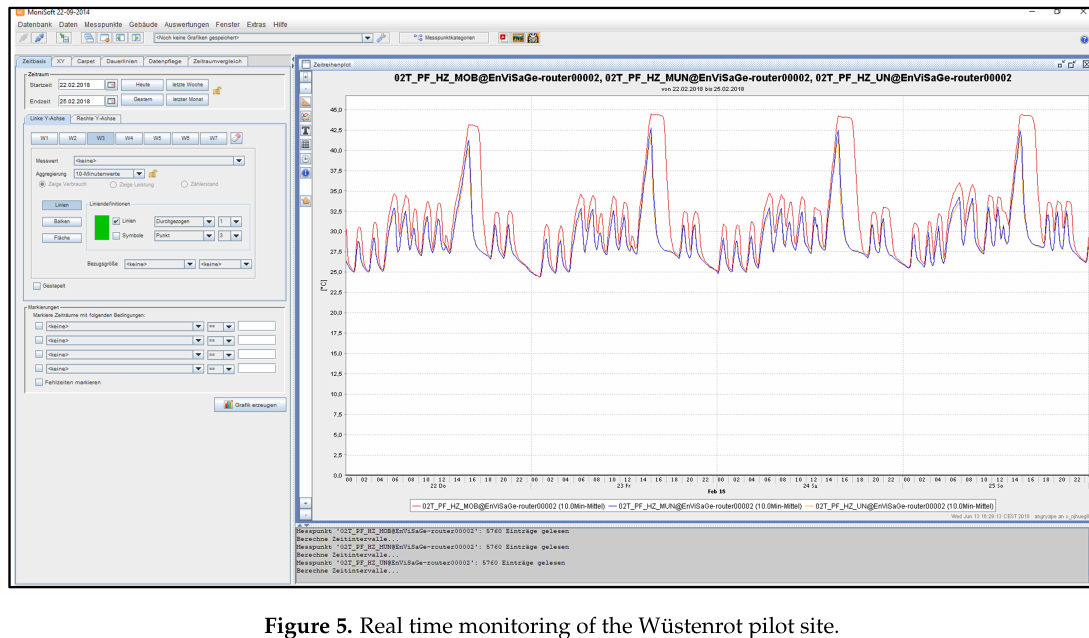
Figure 5. Real time monitoring of the Wüstenrot pilot site.